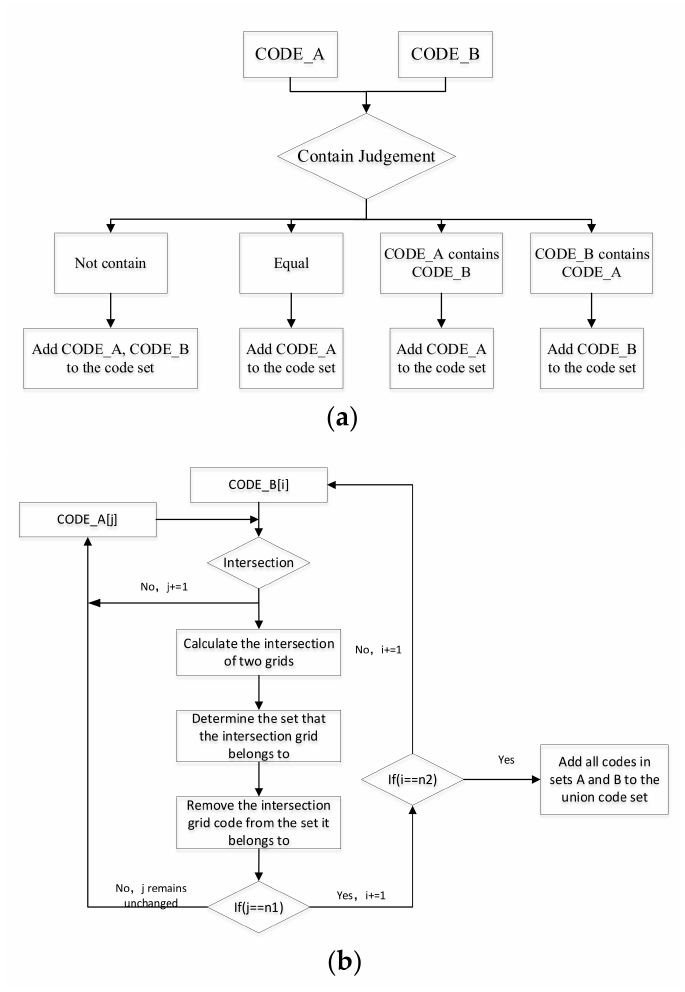
Figure 13. Union operation: ( a ) for two grids; ( b ) for two sets of